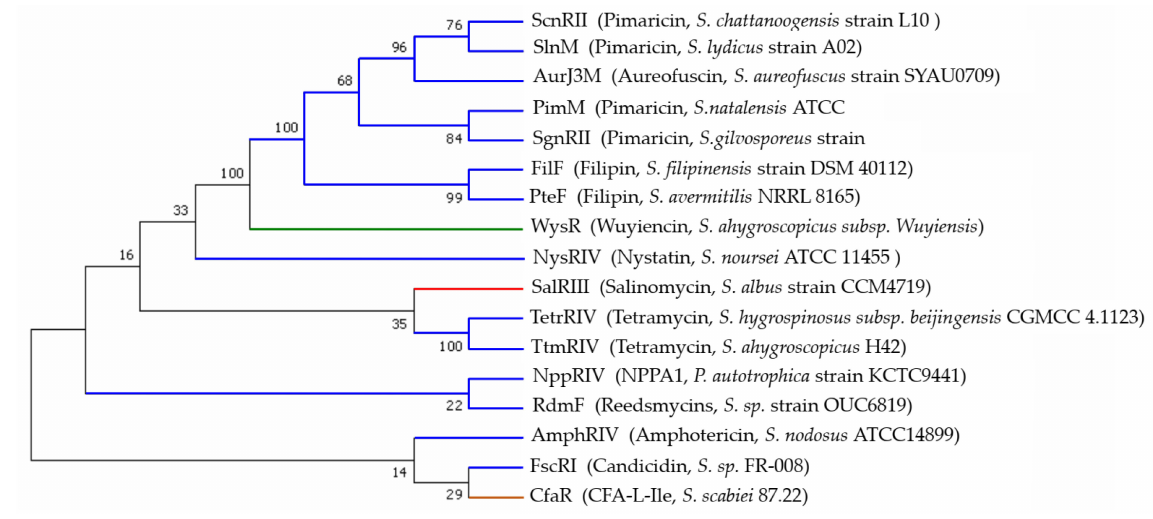
Figure 6. Phylogenetic tree of PAS-LuxR family